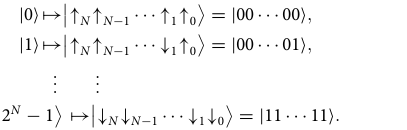
(cid:1) (cid:3) ^ a y ^ a s , while the sub-sub diagonal elements contribute to